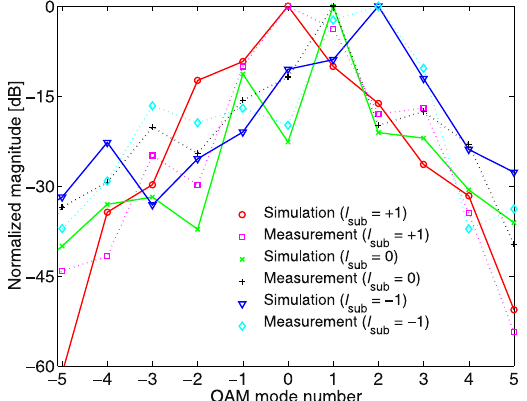
Figure 5. Simulated and measured normalized OAM modal magnitudes versus OAM mode numbers in the = + − were simulated and measured at far-field at 18 [GHz]. The normalized modal magnitudes for l 1, 0, 1 sub = + . The near-field distributions in Fig. 3 were first measured in the θ =    4 , 5 , 6 , respectively, when l 1 main planar near-field range and then transformed to obtain the far-field azimuthal patterns and normalized modal magnitudes of the corresponding OAM mode numbers.